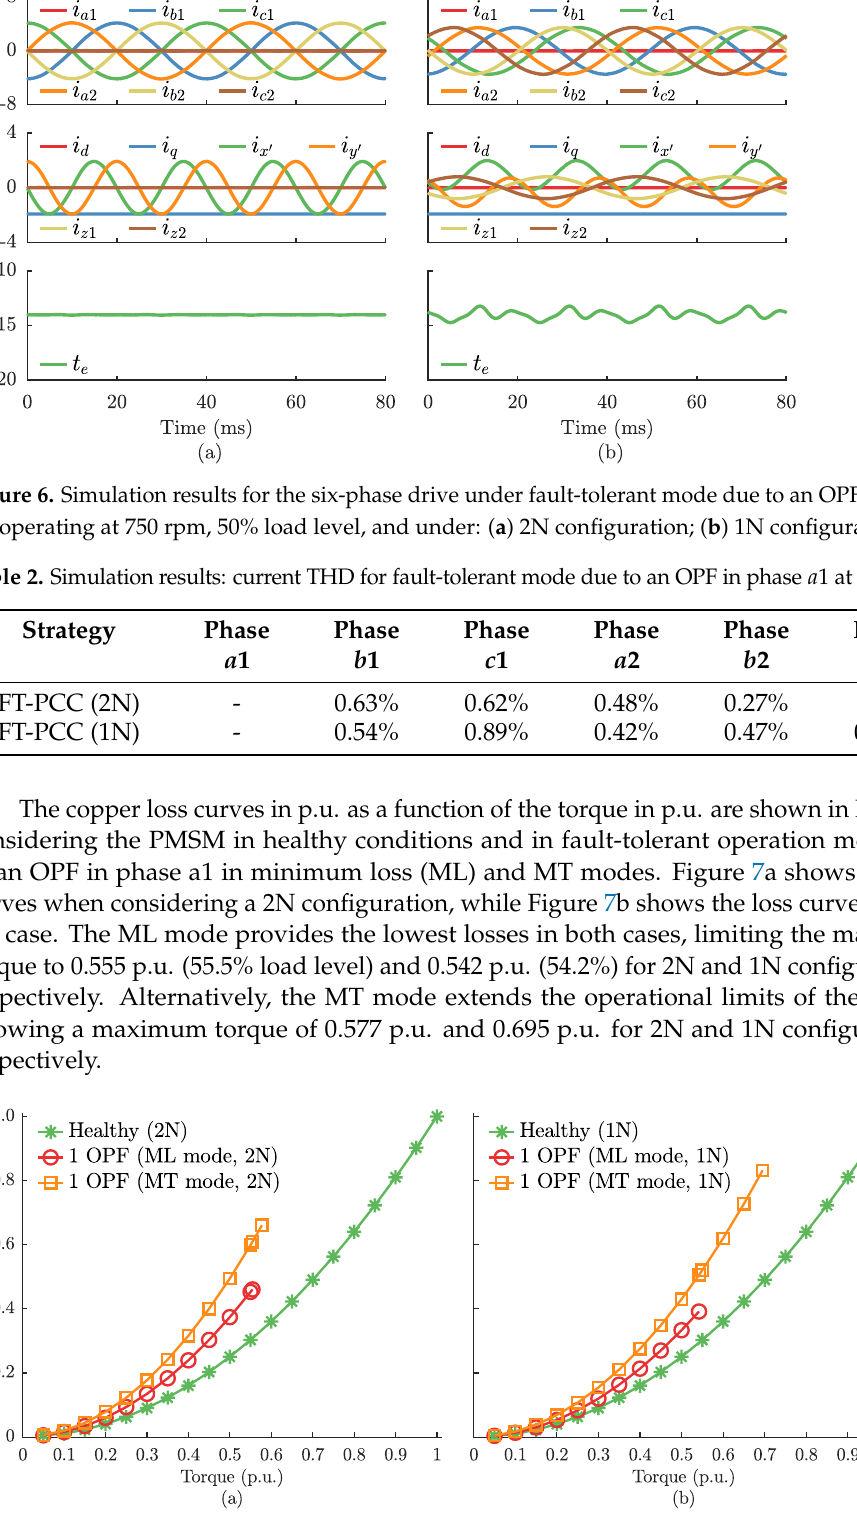
Figure 7. Simulation results for the average copper losses at different load levels obtained for the six-phase drive under: ( a ) 2N configuration; ( b ) 1N